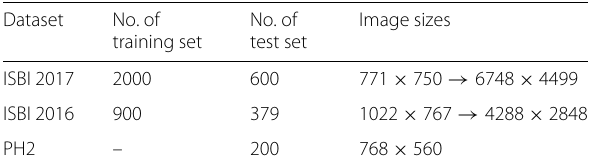
Table 2 Datasets